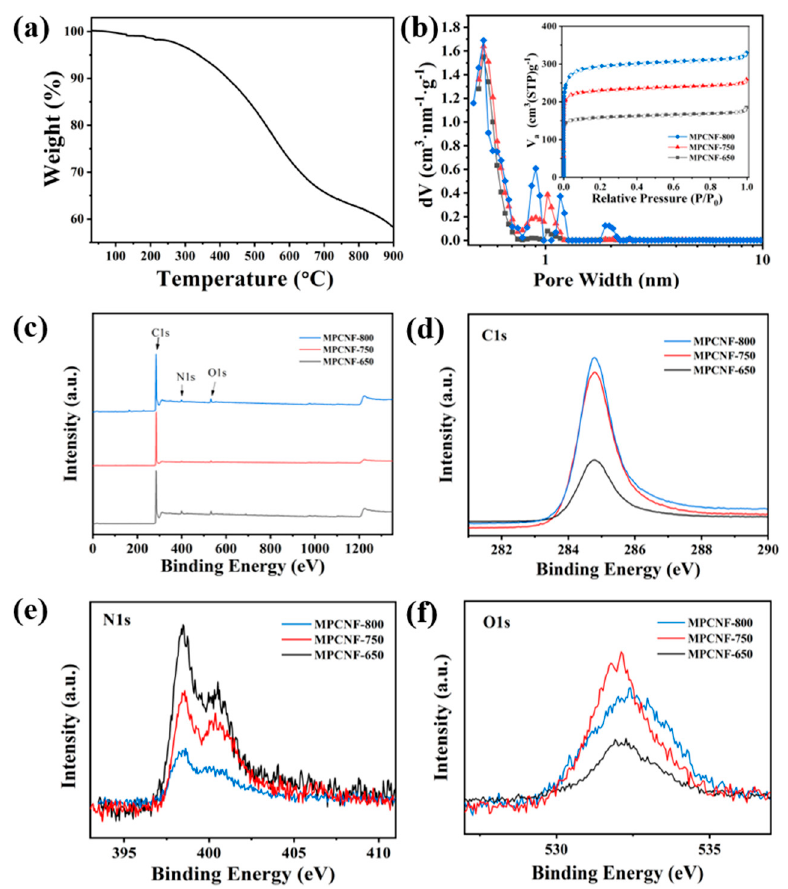
Figure 3. ( a ) Thermogravimetric curve of the cured polymer nanofibers. ( b ) Pore size distribution and isothermal adsorption-desorption curves (inset) of MPCNF − 650, MPCNF − 750 and MPCNF − 800. ( c ) XPS spectrum of MPCNF − 650, MPCNF − 750 and MPCNF − 800. High resolution spectra of ( d ) C1s, ( e ) N1s and ( f ) O1s for the different samples. Table 1. Porosity parameters and contents of C, N, O